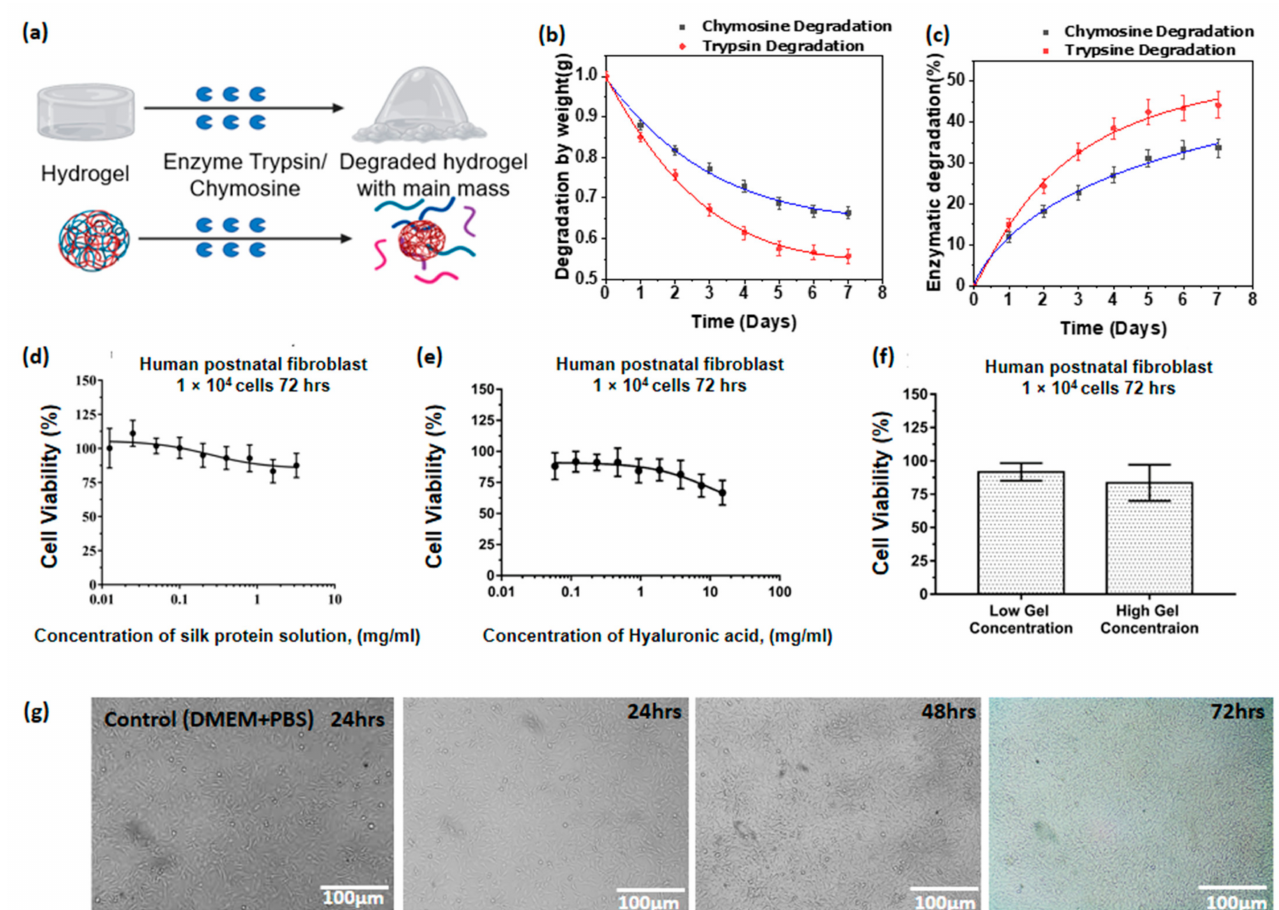
Figure 5. ( a ) Degradation process of hydrogels with enzyme chymosin and enzyme trypsin under physiological conditions (37 ◦ C), degraded minor polymer particles surrounded by main mass are shown. ( b ) Degradation by weight of hyaluronic acid/spider silk-based hydrogels with enzyme chymosin and trypsin over seven days (HA/Ss 2). ( c ) Degradation percent- age of hyaluronic acid/spider silk-based hydrogels with enzyme chymosin and trypsin compared to their initial weight (HA/Ss 2). ( d ) Cytotoxicity assay (MTT assay) of spider silk solution according to the hydrogel preparatory concentrations. ( e ) Cytotoxicity assay (MTT assay) of hyaluronic acid solution according to the hydrogel preparatory concentrations. ( f ) Cytotoxicity assay (MTT assay) of hyaluronic acid /spider silk mixtures according to the hydrogel preparatory concentra- tions. High gel concentration (HA concentration = 15 mg/mL; spider silk concentration = 3 mg/mL); low gel concentration (HA concentration = 0.12 mg/mL; spider silk concentration = 0.025 mg/mL). ( g ) Cell viability on hyaluronic acid/spider silk-based hydrogels (HA/Ss 2) with human fibroblast cells after 24 h, 48 h, and 72 h of cell proliferation intervals in comparison with the control (DMEM +